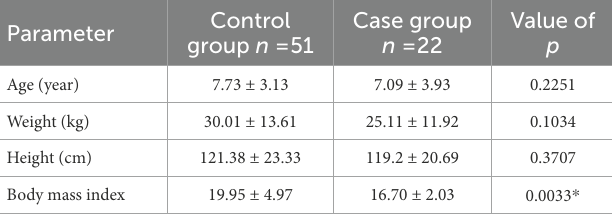
TABLE 1 Characteristics of Saudi female patients with autism and controls without autism.